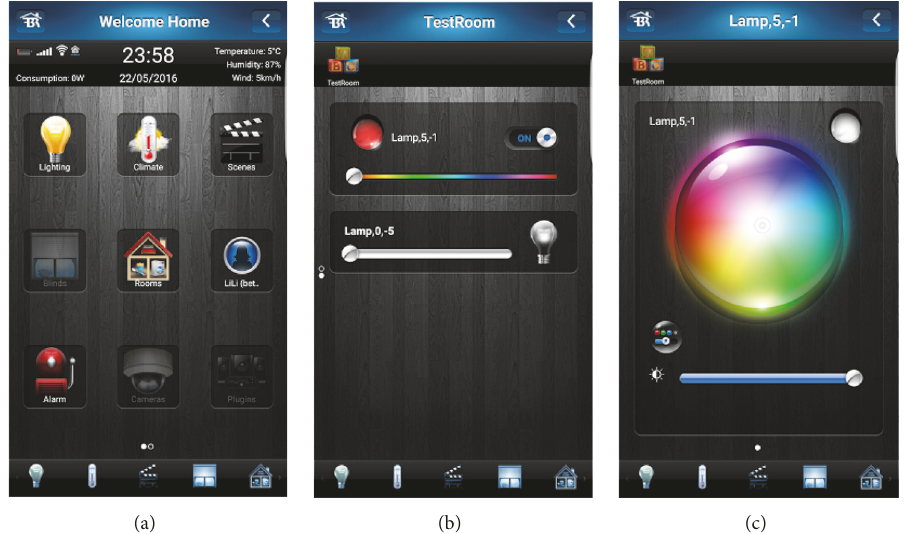
Figure 4: The Fibaro application. (a) The main screen. (b) A specific room is selected and corresponding devices are listed. (c) A dimmable lamp icon with color adjustments is selected to control a lamp.